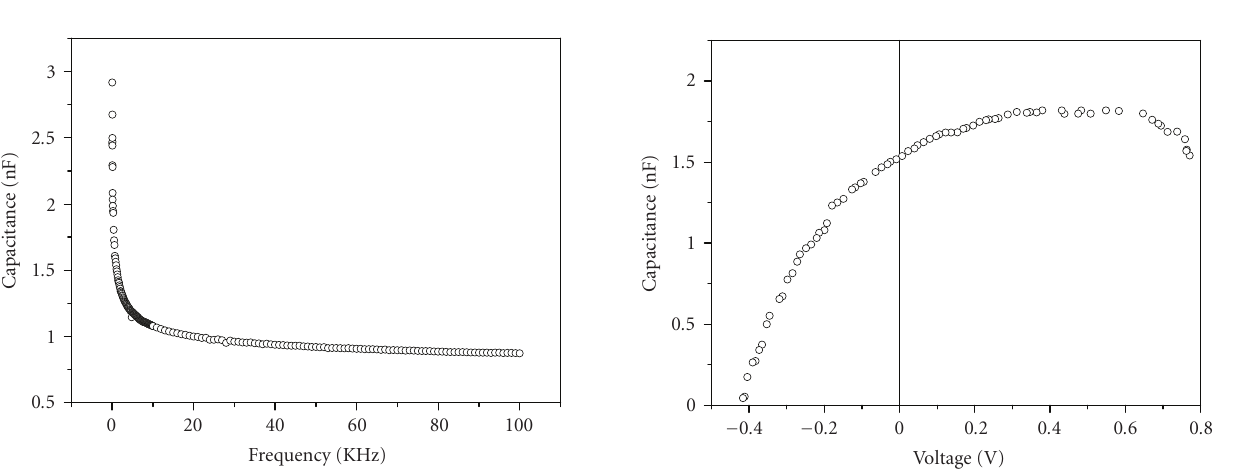
Figure 10: Capacitance-voltage characteristic of ITO/POT/Al